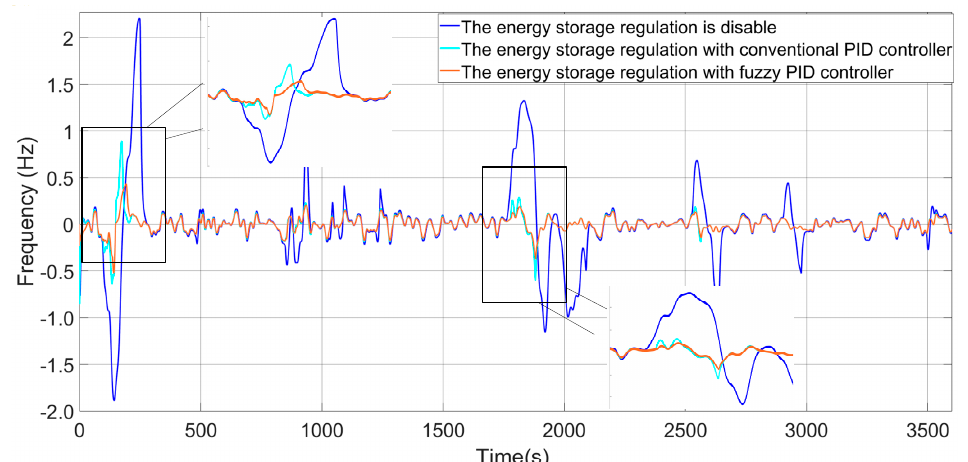
Figure 15. Results of the proposed control strategy under strong perturbation.